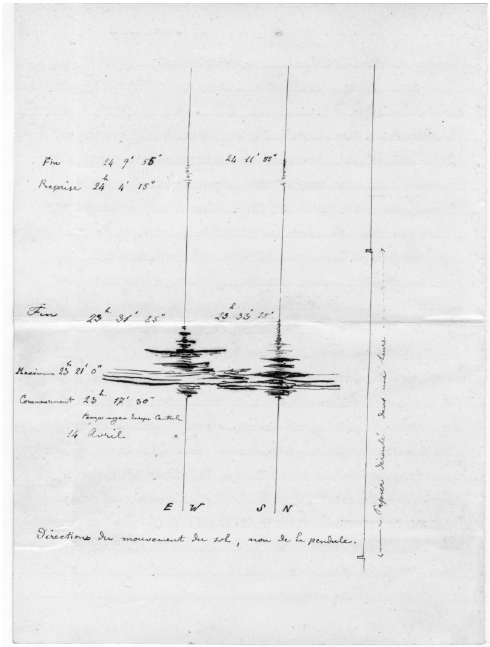
Fig. 2. Letter from Emilio Oddone probably addressed to Albin Belar, director of the observatory of Ljubljana concerning the earthquake on 14th April 1895. The im- age reproduces the seismogram of the earthquake as recorded at Pavia (INGV Archive,